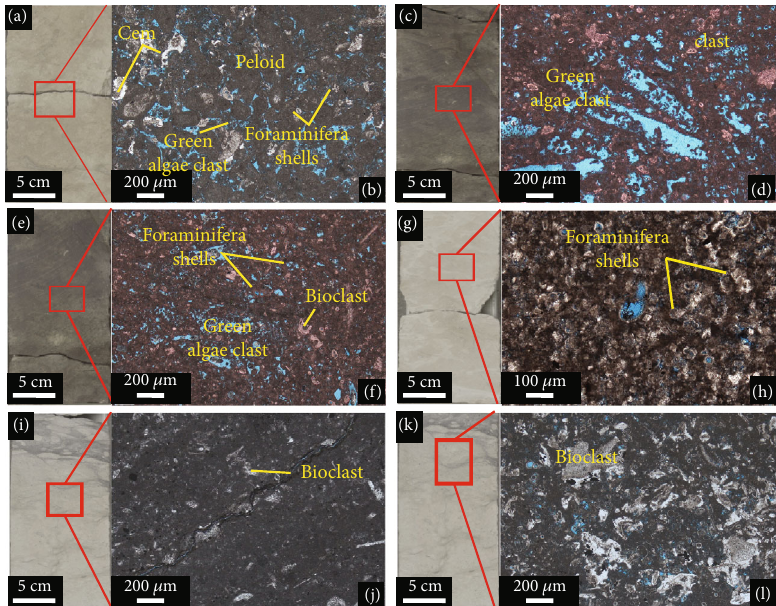
Figure 2: Rock type of the K formation: (a) and (b) are the core and the thin section picture of RT1 and H11 well (2604.00-2604.50 m), (c) and (d) are pictures of RT2 and H2 (2658.50-2658.65m), (e) and (f) are pictures of RT3 and H11 (2614.35-2614.50m), (g) and (h) are pictures of RT4 and B1 (2604.00-2604.15m), (i) and (j) are pictures of RT5 (no visible pores) and B1 (2628.00-2628.50m), and (k) and (l) are pictures of RT6 (no visible pores) and B1